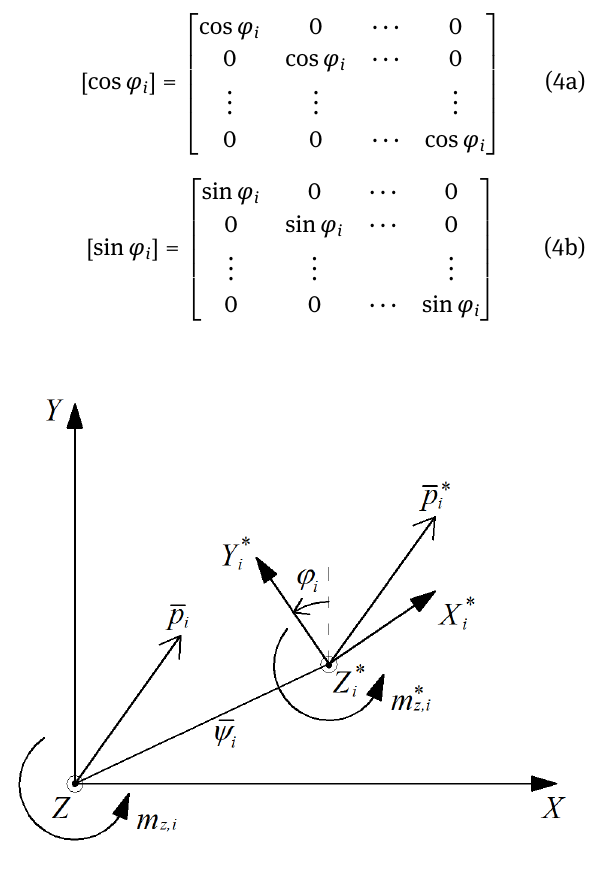
Figure 2: Global and local coordinate